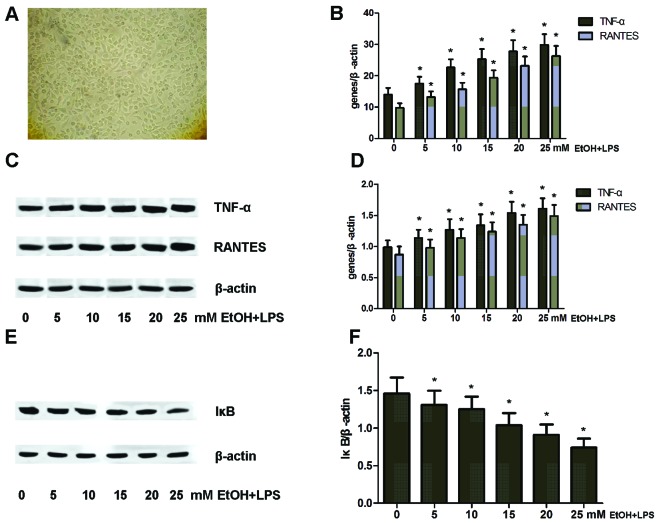
Chronic alcohol exposure upregulates tumor necrosis factor (TNF)-α and regulated upon activation, normal T cell expression and secreted (RANTES) expression in rat macrophages. (A) Cultured rat macrophages (magnification, ×400, F200). (B) mRNA expression of TNF-α and RANTES in rat macrophages exposed to varying doses (0, 5, 10, 15, 20 and 25 mM) of alcohol [ethanol (EtOH)] and lipopolysaccharide (LPS); *P<0.05 vs. 0 mM EtOH + LPS group. (C) Protein expression of TNF-α and RANTES in rat macrophages exposed to varying doses (0, 5, 10, 15, 20 and 25 mM) of alcohol and LPS. (D) Protein expression was analyzed using BandScan 5.0 software and normalized to β-actin; *P<0.05 vs. 0 mM EtOH + LPS. (E) Western blot analysis of IκB expression in rat macrophages exposed to varying doses (0, 5, 10, 15, 20 and 25 mM) of alcohol and LPS. (F) Protein expression was analyzed using BandScan 5.0 software and normalized to β-actin; *P<0.05 vs. 0 mM EtOH + LPS.